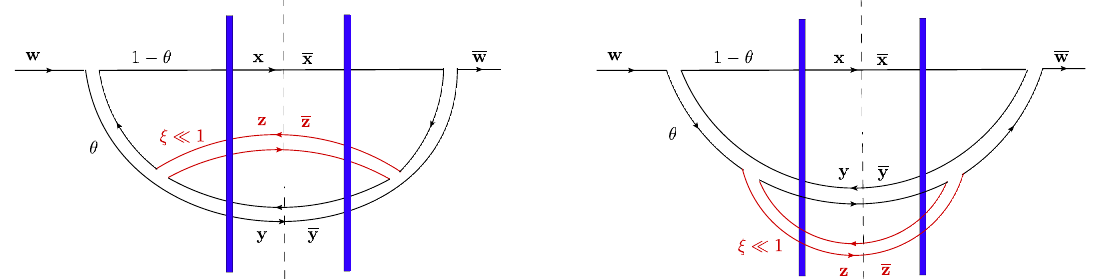
Figure 17 . A redrawing of the first graph in figure 16 valid at large N c which exhibits the 2 colour structures hidden in this graph: each gluon is replaced by a double line denoting a quark-antiquark pair of zero transverse size. These two large- N graphs correspond to the first terms in the first c and, respectively, second squared bracket in eq.